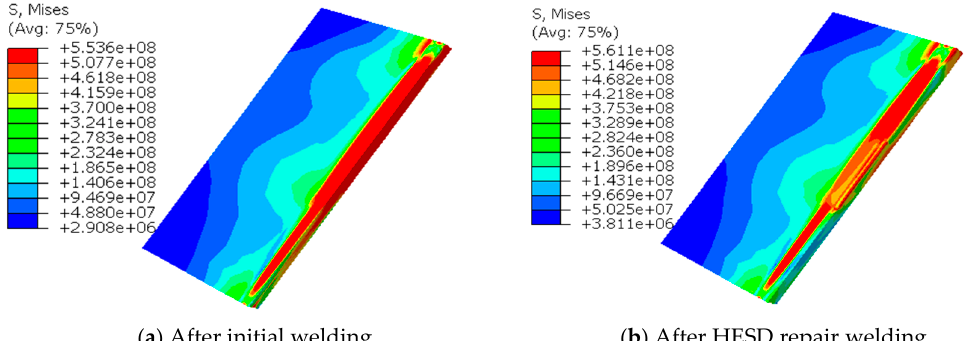
Figure 18. Stress contour after the initial welding and HESD repair welding.